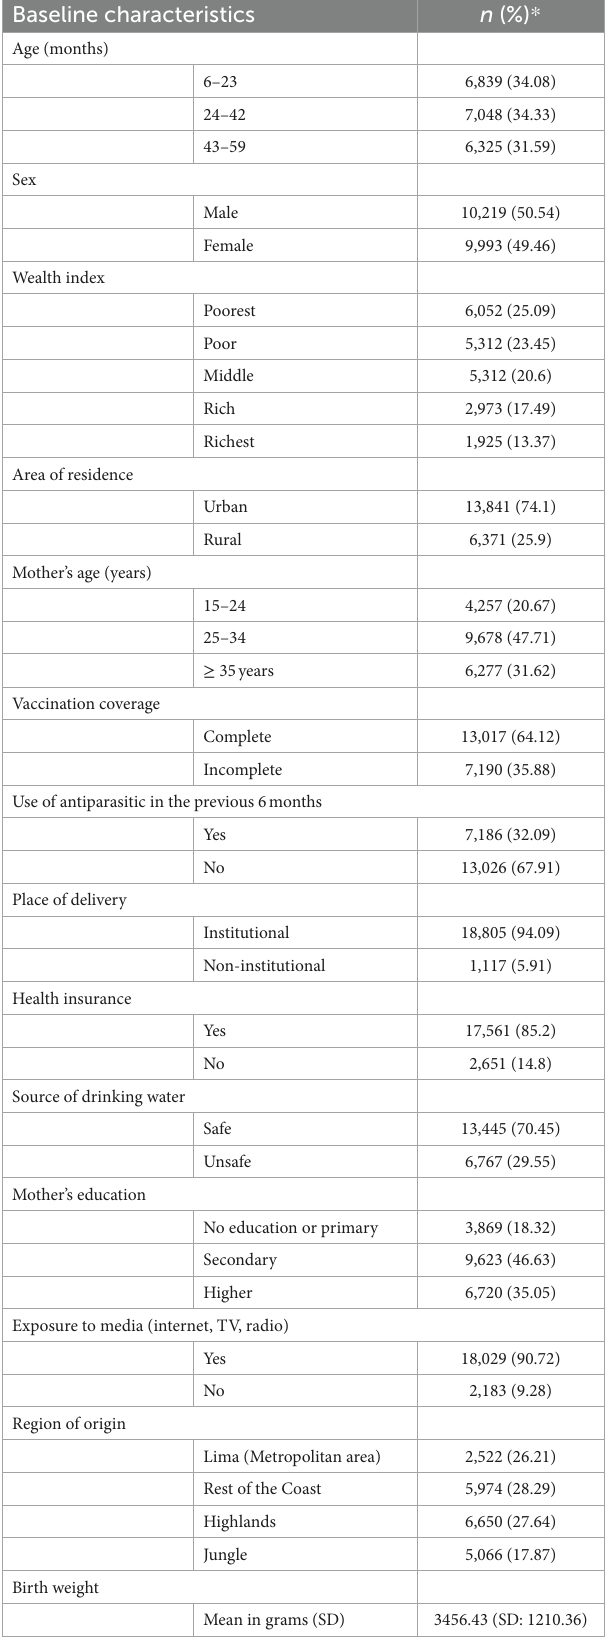
TABLE 1 Demographic and socioeconomic characteristics of Peruvian children aged 6–59 months. Baseline